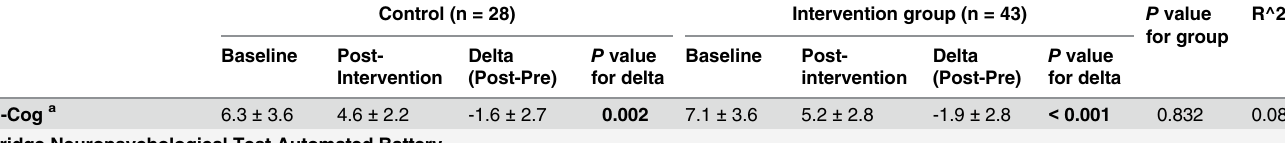
Table 3. Changes in cognitive functions between the control and the intervention